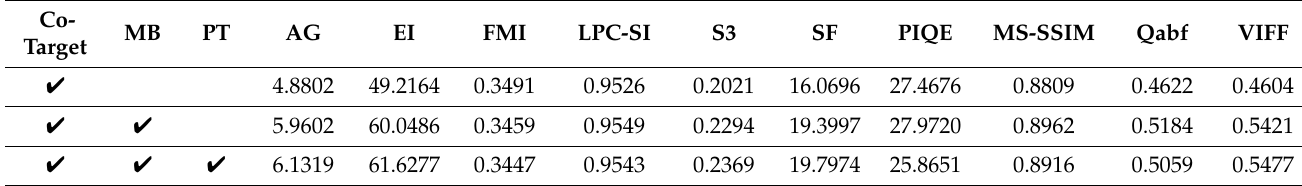
Table 2. Comparison of image-quality metrics score between the proposed methods: Co-target denotes correct-exposed image target, and MB and PT denote the MaskBuilder and the Param- Tuner,